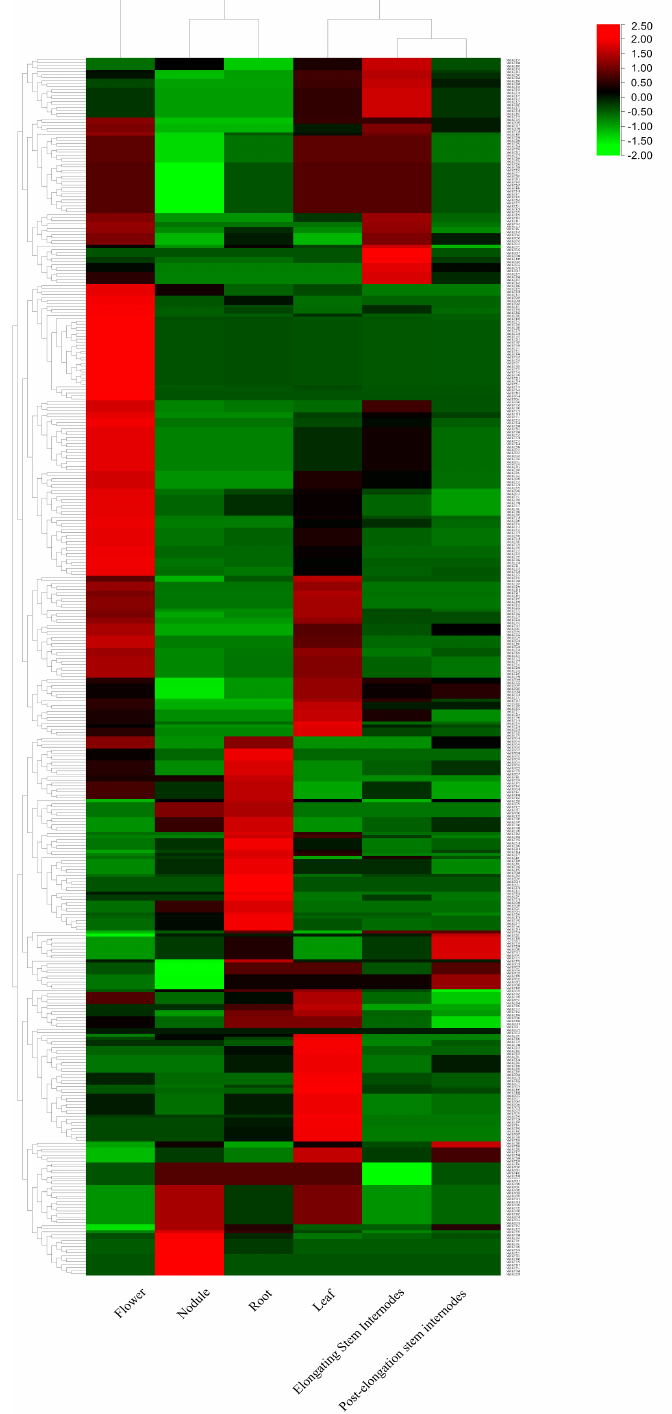
Figure 4. Expression profile of MsUGT genes in six different tissues (flower, nodule, root, leaf, elon- gating stem internodes, post−elongation stem internodes). The data were retrieved from transcrip- tome datasets. The heatmap was constructed by TBtools software (v1.098745, Chen, C. J.,